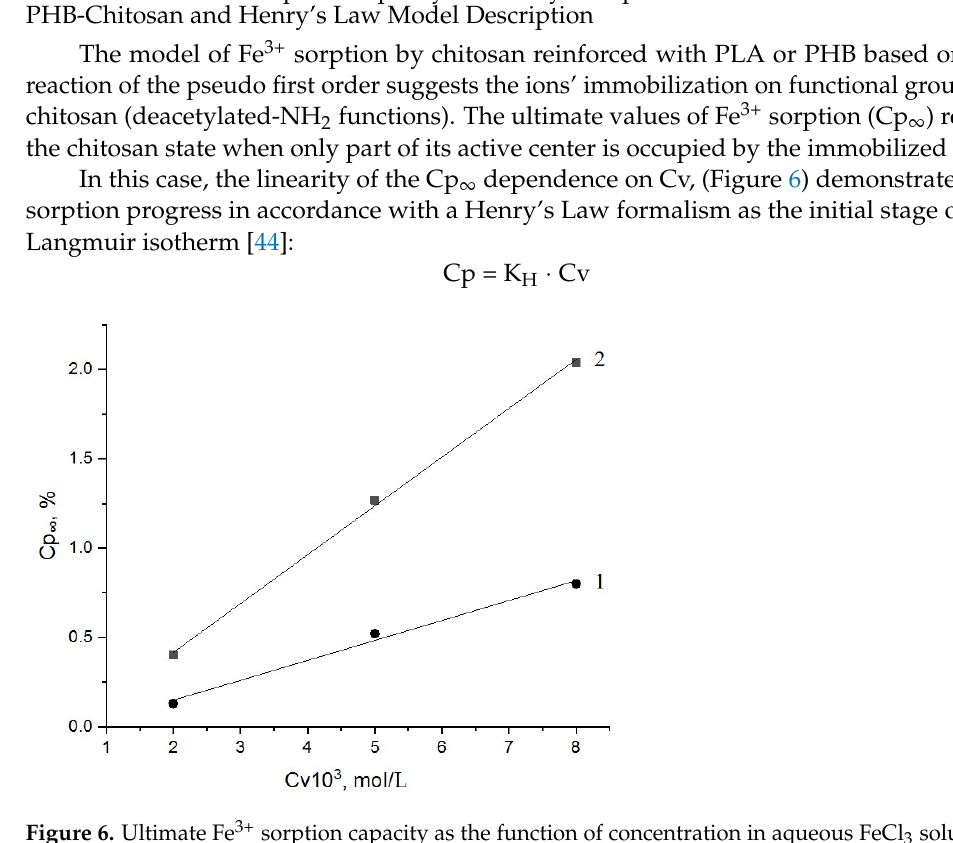
Figure 6. Ultimate Fe 3+ sorption capacity as the function of concentration in aqueous FeCl 3 solutions with different molar contents (Cv) for PLA (1) and PHB (2).